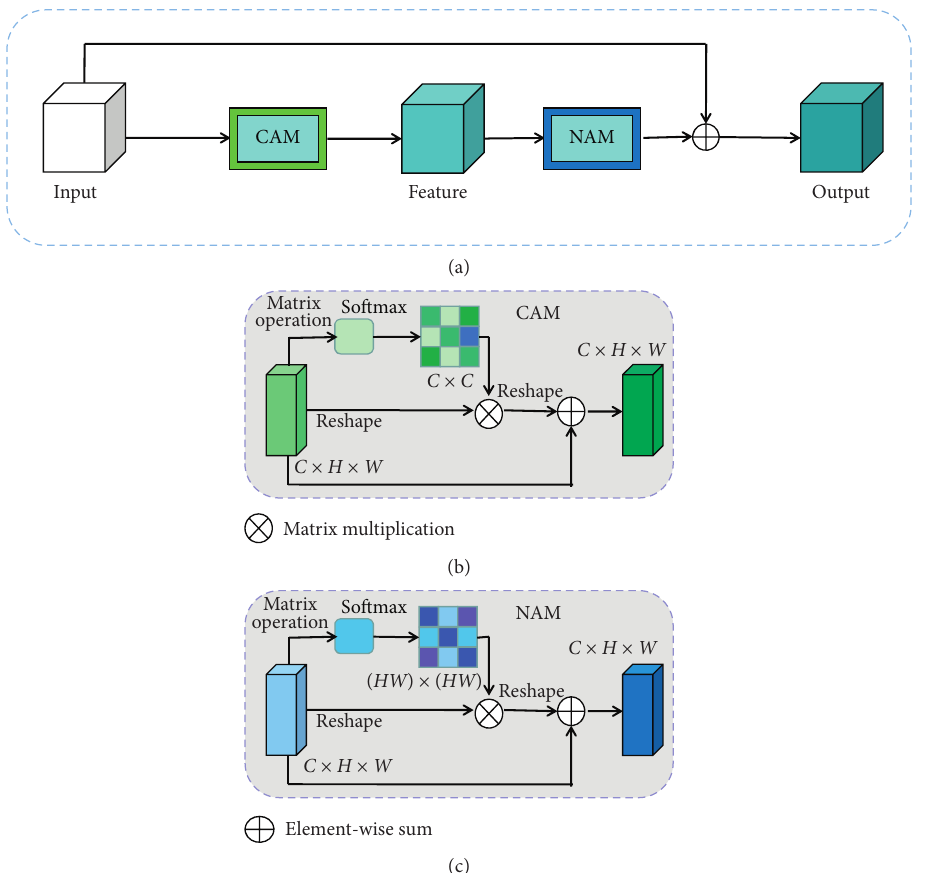
Figure 3: Structure of Combined Attention Fusion Module. (a) CAFM. (b) CAM. (c)